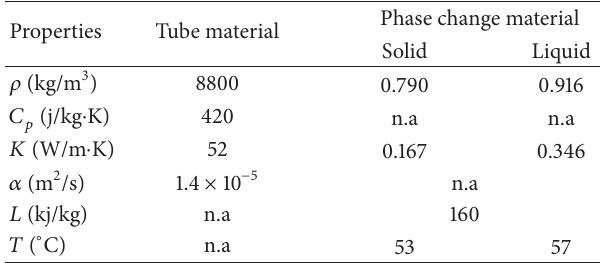
Table 1: Thermophysical properties of the PCM and